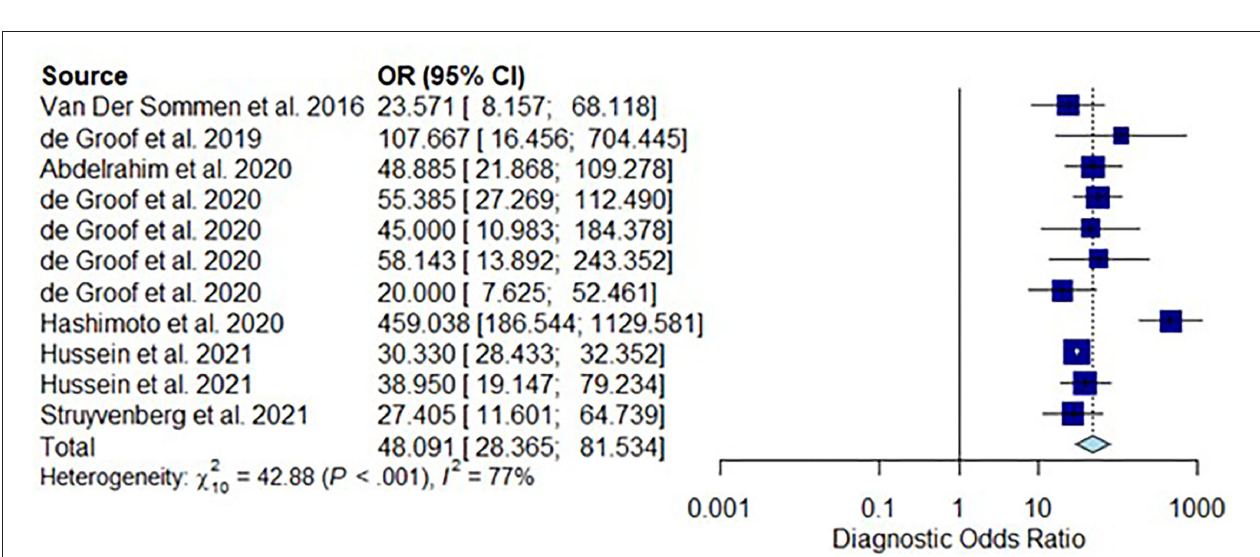
FIGURE 4 | Forest plots of pooled diagnostic odds ratio for all included studies of AI and the detection of early BE neoplasia.